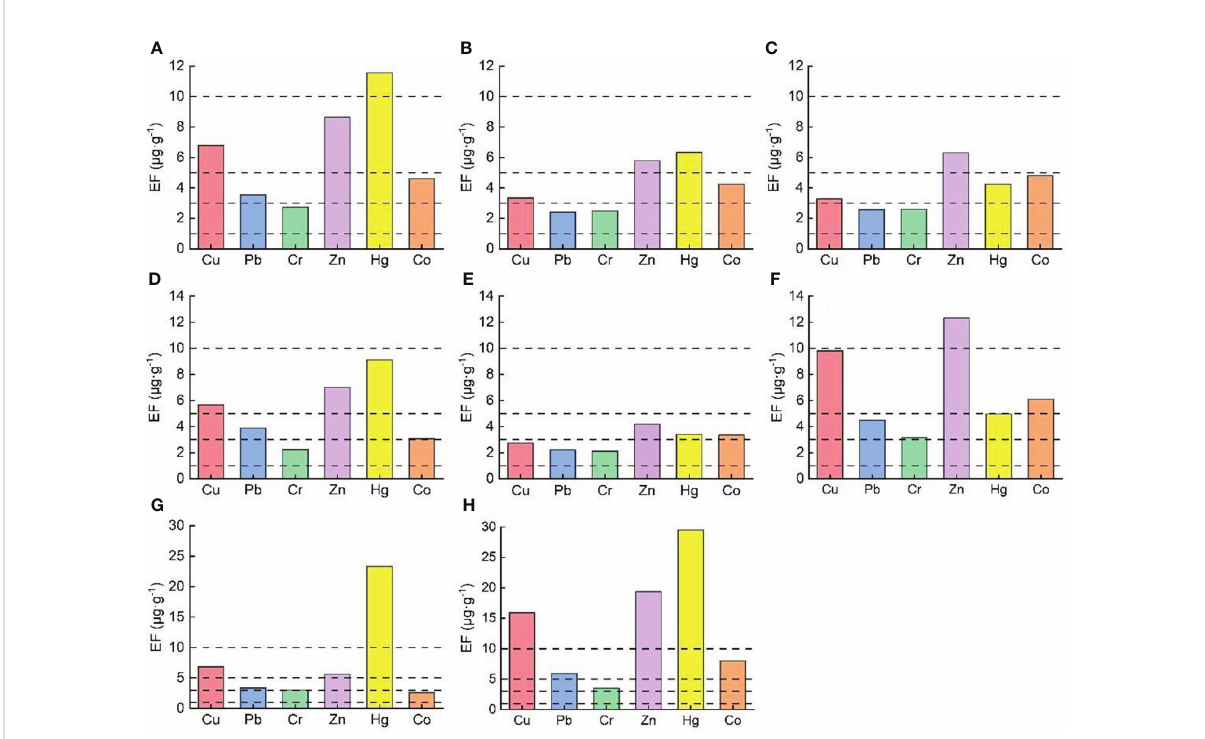
FIGURE 6 EF Results of mangrove surface sediments in Zhanjiang Bay. ( A – H represent: Total Zhanjiang Bay, DC, DTS, NS, SDJ, DM, BY, GHCL,